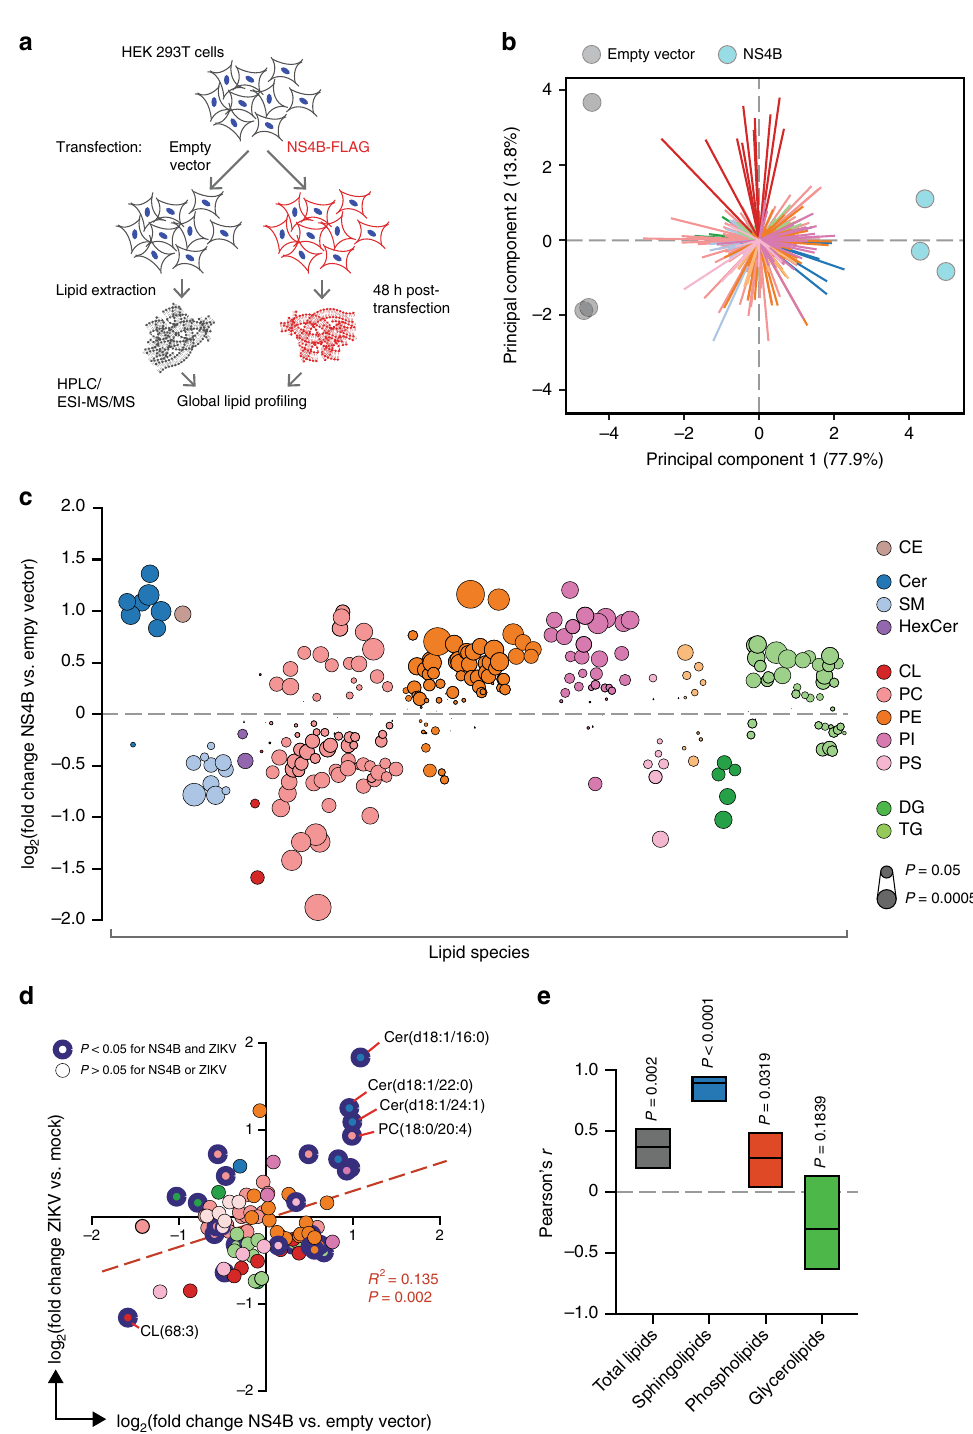
Fig. 2 ZIKV NS4B dysregulates host lipid metabolism. a Design of transfection experiment. Total lipids were extracted from HEK 293T cells transfected with NS4B or an empty vector control; n = 3 biological replicates per condition. b PCA of the lipidomics dataset. Colored arrows represent individual lipid species. c Bubble plots of log2 fold changes in abundance of lipid species in ZIKV-infected cells relative to mock at 24 hpi. Bubble size represents P value from one-way ANOVA or g test. d Correlation of log2 fold-change values of lipid species ( n = 95) identi fi ed in both ZIKV-infection and NS4B-transfection experiments (see Supplementary Data 1 and 2, respectively). Linear regression best- fi t line ( y = 0.3212 × 0.02533), R 2 , and P values are shown. e Pearson ’ s correlation coef fi cient ( r ) for total or subclasses of lipid pairs. Lines and bars are r values with 95% CI, respectively. See also Supplementary Fig. 3, Supplementary Data 2, and the Source Data fi